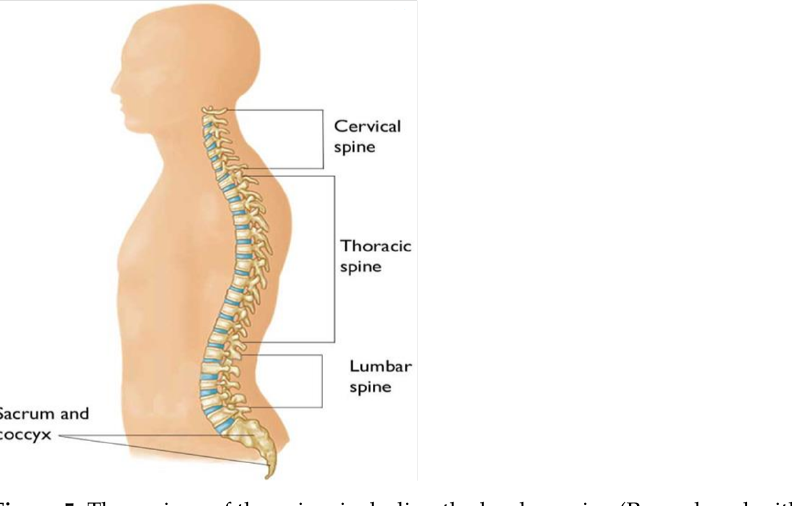
Figure 5. The regions of the spine, including the lumbar spine (Reproduced with permission from OrthoInfo. © American Academy of Orthopaedic Surgeons. https://orthoinfo.org/ accessed on 20 February 2022)